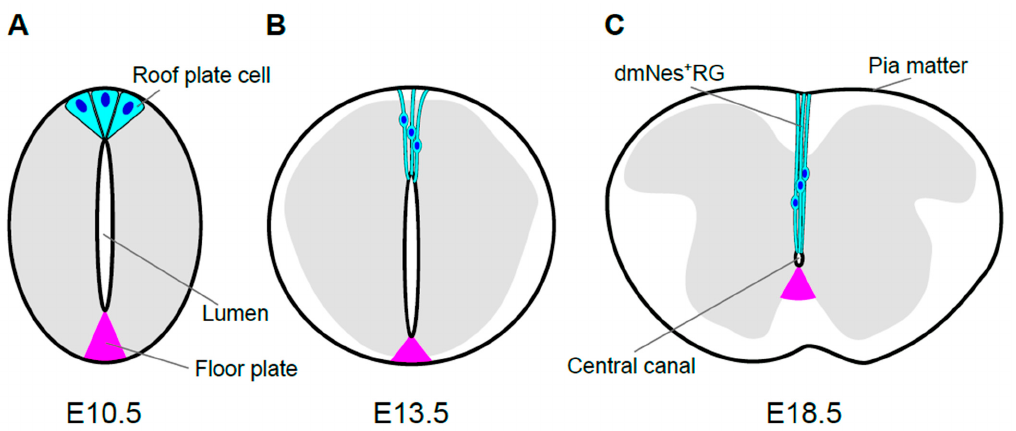
Figure 2. Morphological transformation of the mouse spinal cord. Schematic images of spinal cord morphology and roof plate shape are shown at E10.5 ( A ), E13.5 ( B ), and E18.5 ( C ) during mouse development. The gray matter of the spinal cord is shown in gray. Roof plate cells, or their descendants, and their nuclei are shown in cyan and blue, respectively. The size and morphology of spinal cord change dramatically during development. In accordance with these changes, morphology of roof plate cells also transforms. In mouse embryos, the apical sides of roof plate cells gradually constrict, such that roof plate cells assume a wedge-shaped form at E10.5 ( A ). Then, the lumen of the spinal cord shrinks gradually. The reduction of lumen size is caused by gradual attrition of neuroepithelial cells adjacent to roof plate cells. As a result, cell reduction from the surface of the lumen proceeds progressively in a dorsal-to-ventral manner known as dorsal collapse. Accompanying the dorsal collapse and reduction of the lumen, roof plate cells are stretched along the dorso-ventral axis and line up along the midline, resulting in morphological transformation. Compared to the dorsal side, reduction of the ventral ventricular zone and transformation of floor plate (magenta) are comparatively smaller ( B ). The stretched roof plate cells are also known as dorsomedial Nestin-positive radial glia (dmNes + RGs). At E18.5, the diameter of the lumen finally shrinks to roughly a few cell diameters, resulting in the central canal, a cavity filled with cerebrospinal fluid and connected to the ventricular system of the brain. Quiescent neural stem cells locate around the central canal. At this stage, roof plate cells (dmNes + RGs) are stretched, maintaining contact with the inner surface of the central canal and also with the pia mater, which covers the outer surface of the spinal cord ( C